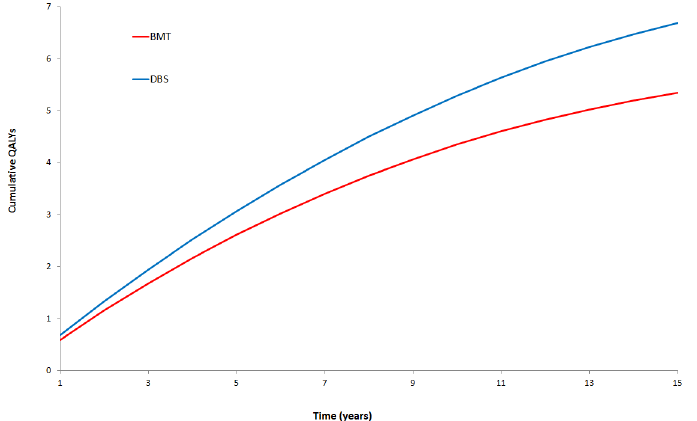
Fig 4. Cumulative discounted QALYs over 15